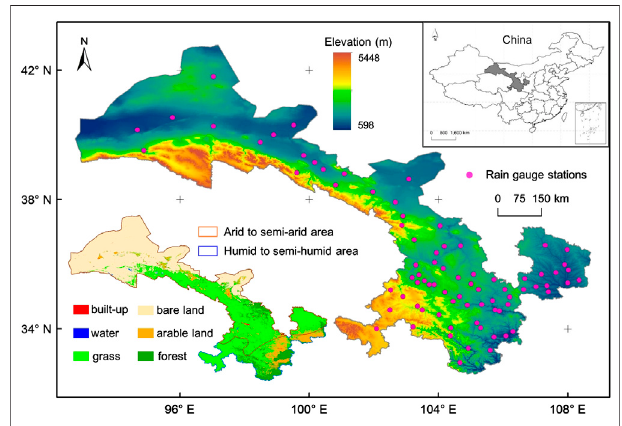
FIGURE 1 | Location of Gansu province and rain gauge stations. The elevation, climate zones, and land cover types are also presented.